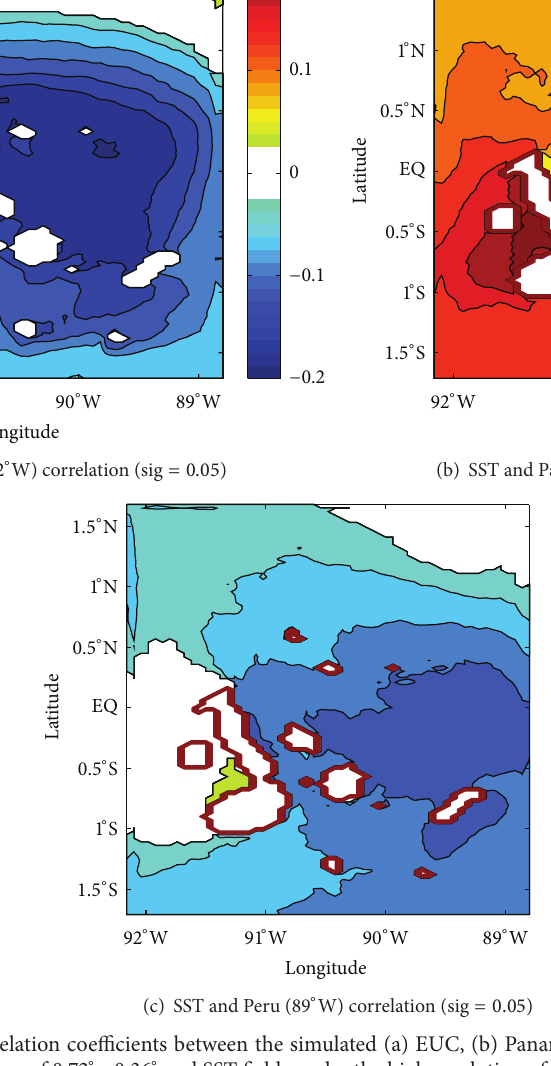
University (NCSU) using the High-Performance Computing (HPC) system at NCSU and the Bluefire supercomputer at